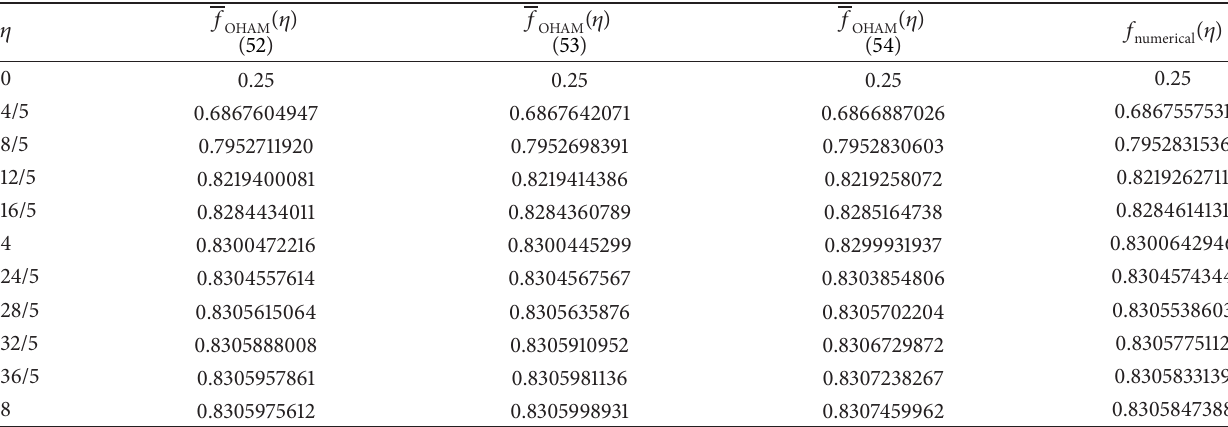
Table 3: Comparison of the first-order approximate solution 𝑓 obtained by OHAM with numerical